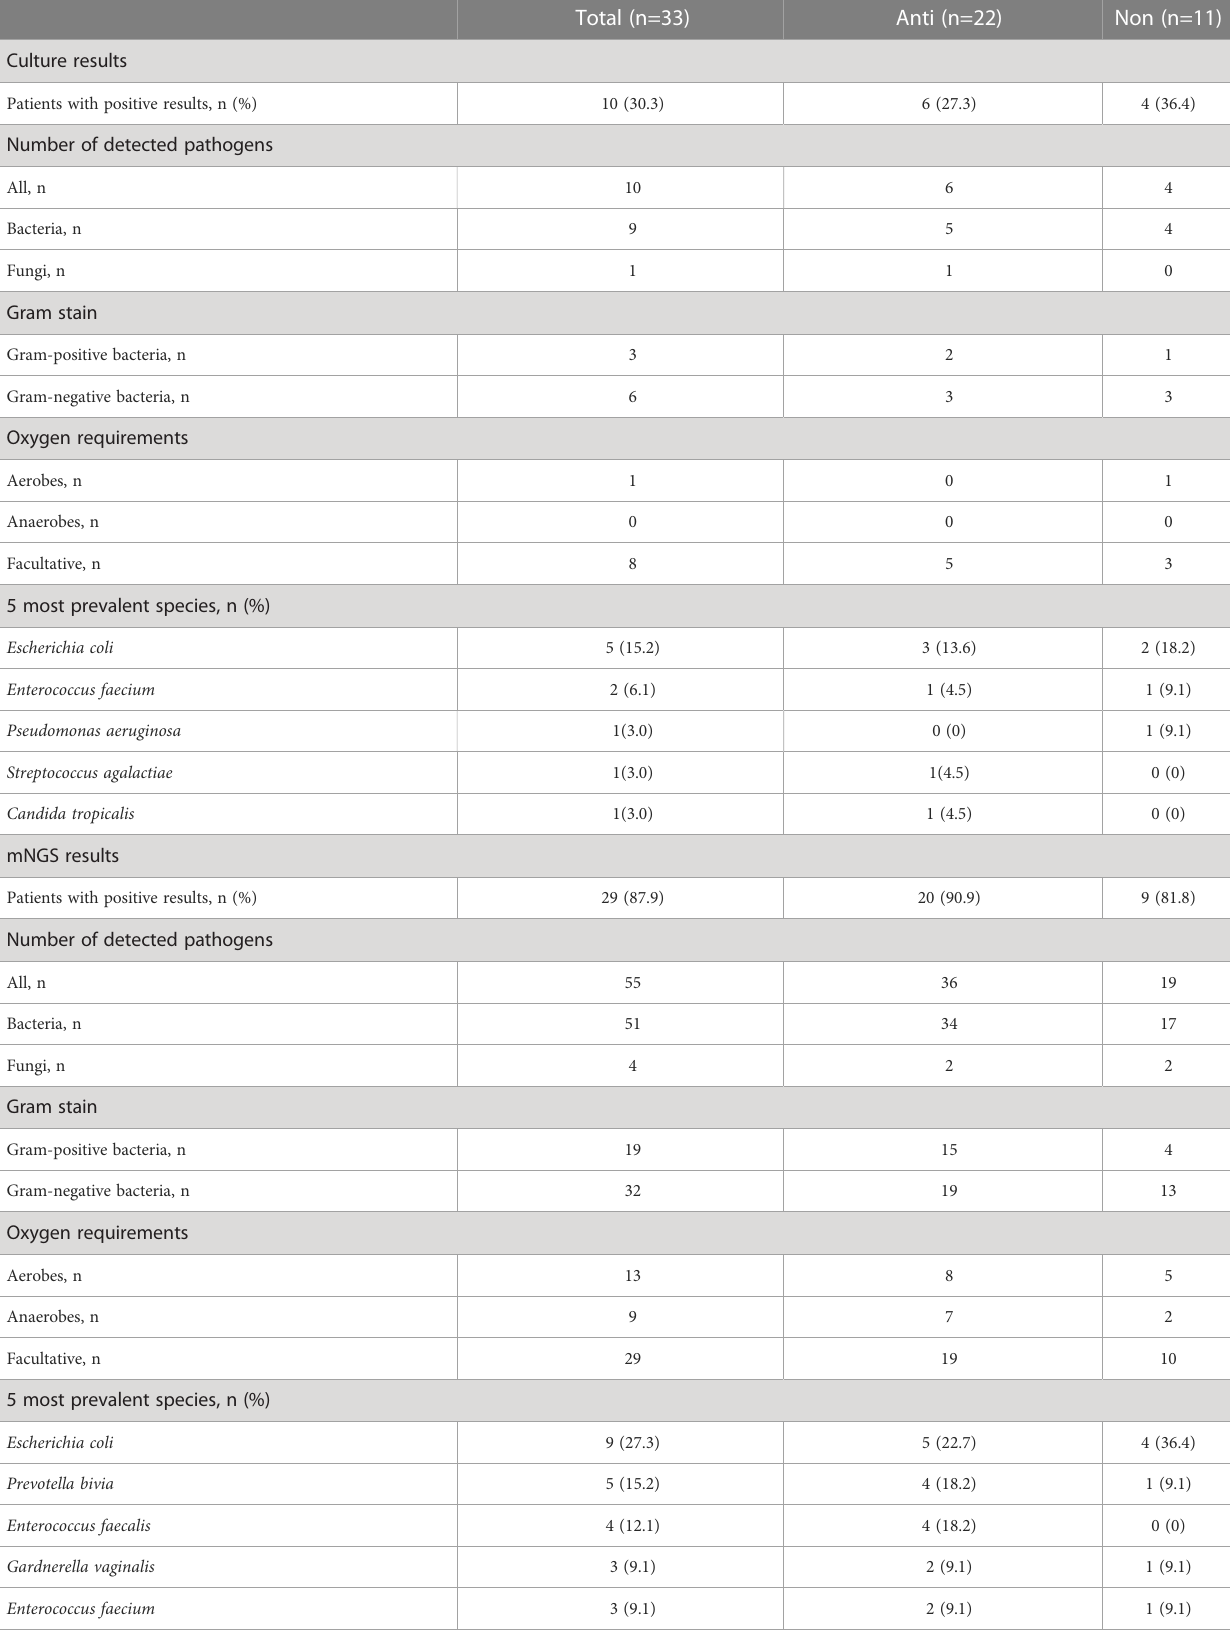
TABLE 5 Overview of traditional cultures and mNGS results in detection of bacteria and